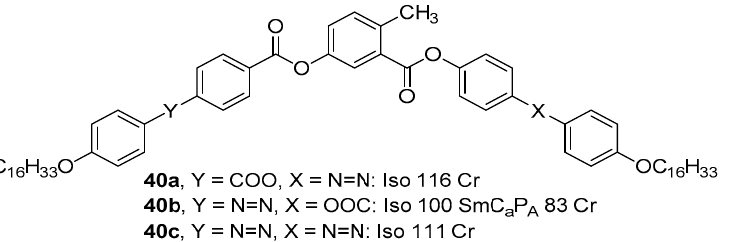
Figure 10. X-ray diffraction (XRD) profile of compound 39a , ( a ) at T = 100 °C in the SmC S1 phase and ( b ) at T = 70 °C in the DC phase. The insets represent the corresponding 2D X-ray pattern at the indicated temperature. (Reproduced with permission from ref. [33], copyright The Royal Society of Chemistry 2017, https://doi.org/10.1039/C7RA05632J).